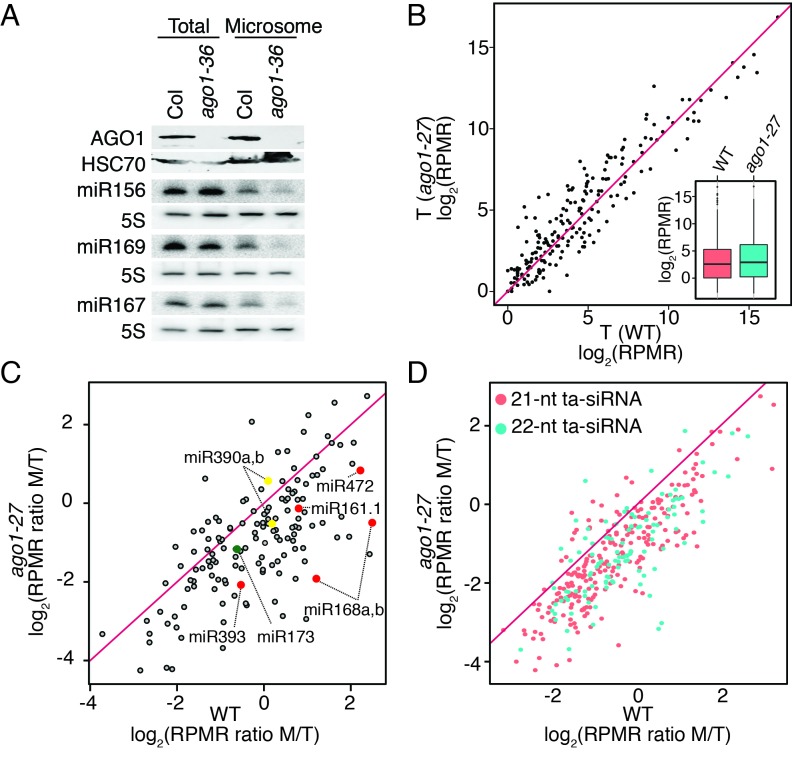
miRNAs and ta-siRNAs are recruited to membranes by AGO1.(A) Detection of three miRNAs in total extracts and the microsomal fraction in wild type (Col) and ago1-36. The ago1-36 mutant lacks the full-length AGO1 protein as shown by western blotting. HSC70 was a loading control. The three miRNAs were detected by northern blotting. 5S rRNA was an internal control and shown below each miRNA blot. The microsomal levels of the miRNAs were reduced in ago1-36. (B) A scatter plot showing comparable miRNA abundance in wild type (WT) and ago1-27 total extracts. Inset: box plots illustrating the distribution of miRNA RPMR values in WT and ago1-27. (C) A scatter plot showing that miRNAs have reduced microsomal enrichment in ago1-27 as compared with wild type. Microsomal enrichment was measured by M/T (ratio of levels in microsome vs. those in total extract). The degree of microsomal enrichment of miR390 (yellow dots) is largely unchanged, while that of most known ta-siRNA/phasiRNA triggers (red dots) is decreased in ago1-27. miR173’s (green dot) microsomal enrichment was weakly affected. (D) A scatter plot showing that 21-nt and 22-nt ta-siRNAs from TAS1-4 loci have reduced microsomal enrichment in ago1-27 as compared with wild type.